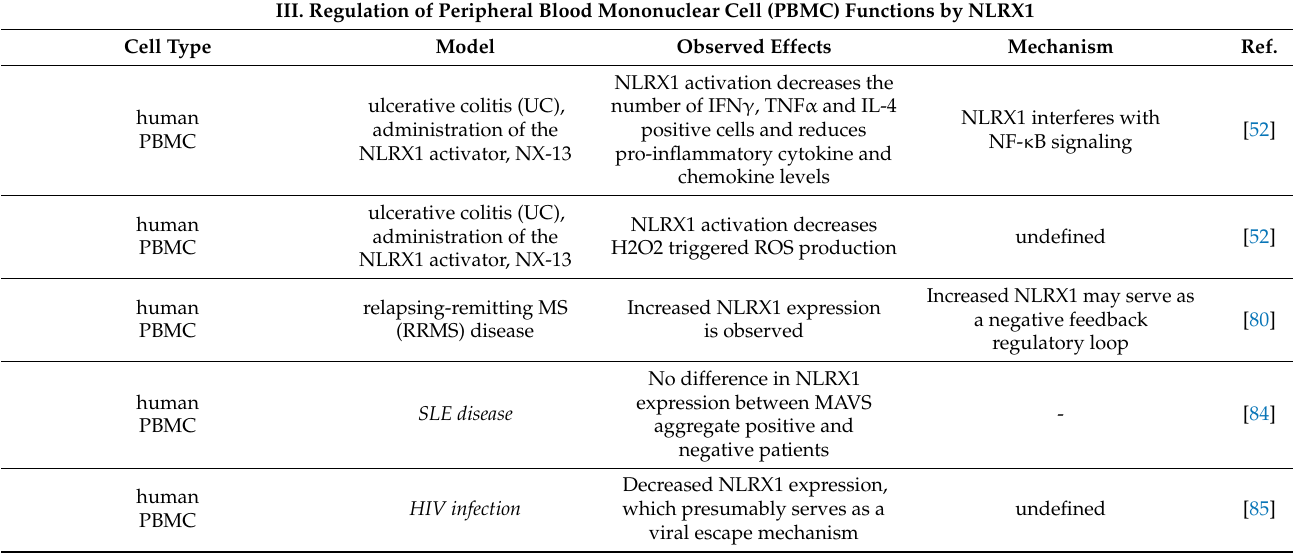
Table 3. Regulation of peripheral blood mononuclear cell (PBMC) function by NLRX1. III. Regulation of Peripheral Blood Mononuclear Cell (PBMC) Functions by